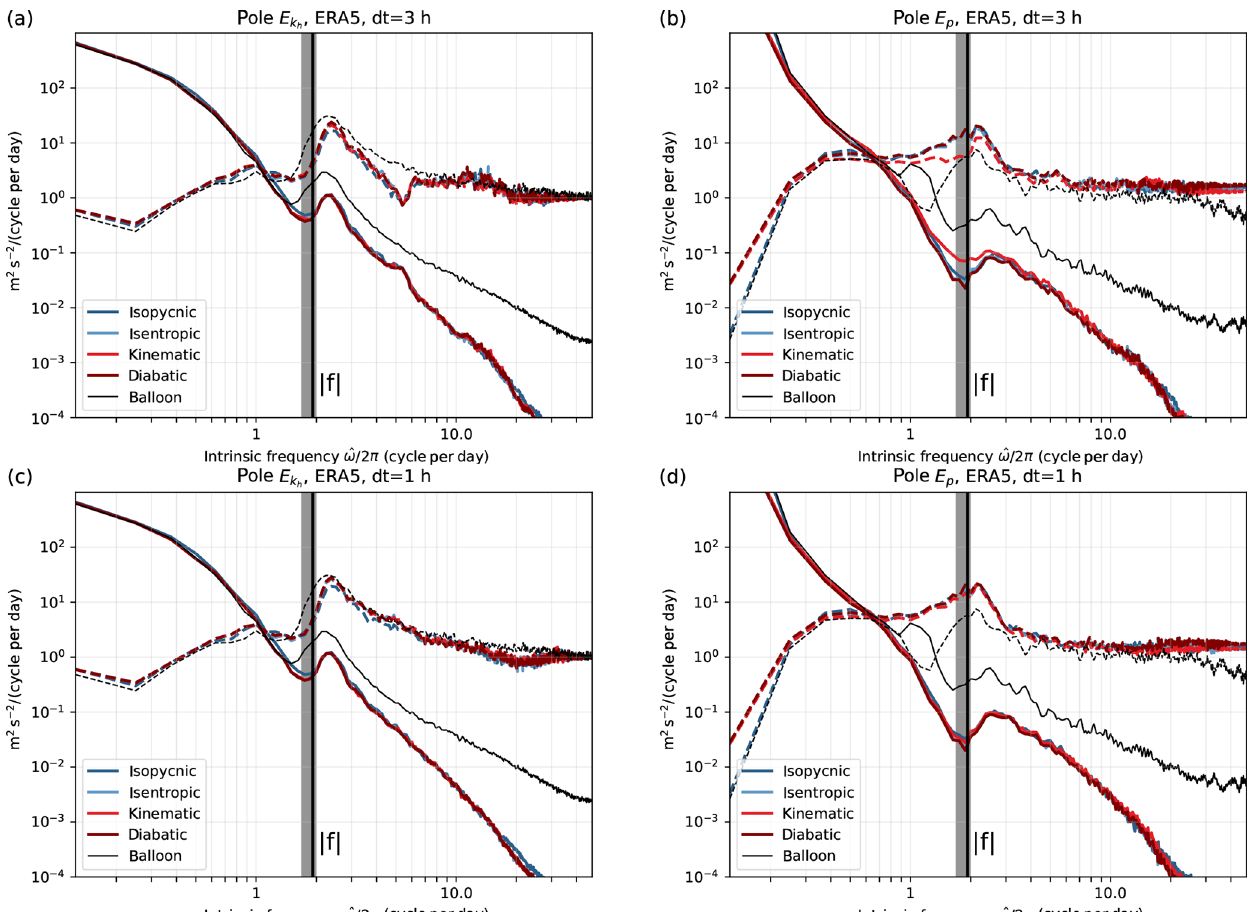
Figure B1. Intrinsic frequency spectra of (a, c) kinetic energy E k and (b, d) potential energy E p per unit mass along ERA5 trajectories h starting at Vorcore balloon locations for different trajectory types: isopycnic (constant ρ ; note that E p spectrum is in that case adjusted following Eq. 3, as is done for the balloons), isentropic (constant θ ) and kinematic and different reanalysis output frequencies ( a , b : 3h; c , d :